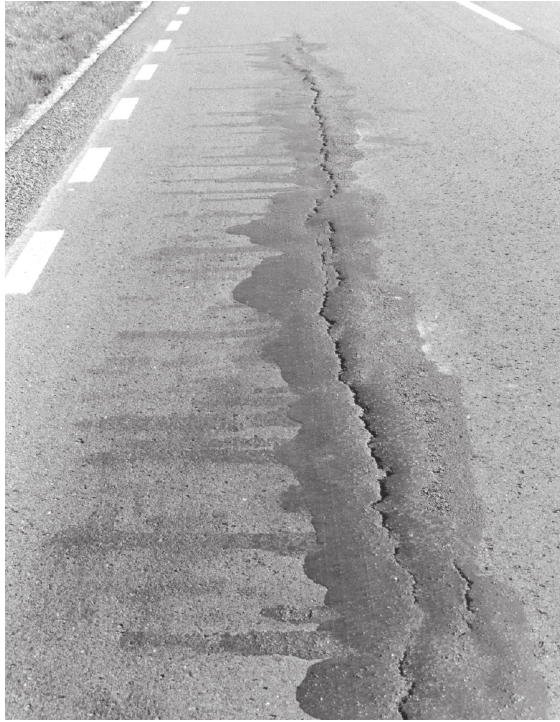
Figure 1: Longitudinal crack in the surface as a result of uneven settlement of the